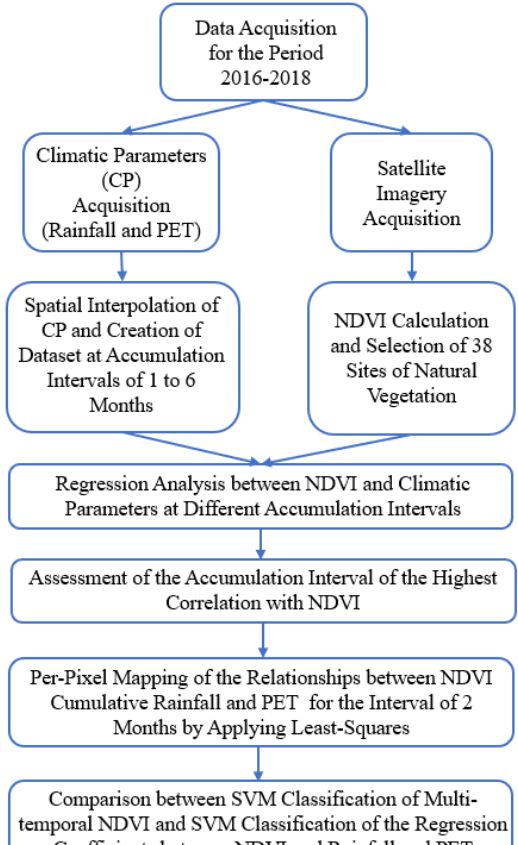
Figure 2: Flowchart of the study